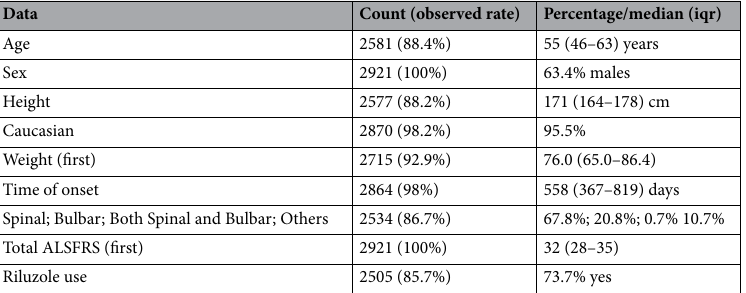
Table 1. ALSFRS/ALSFRS-R cohort descriptive statistics. For each variable, the number and percentage of non missing values within the dataset before imputation, as well as and their percentage or median values are reported. Total ALSFRS and weight refer to the first available